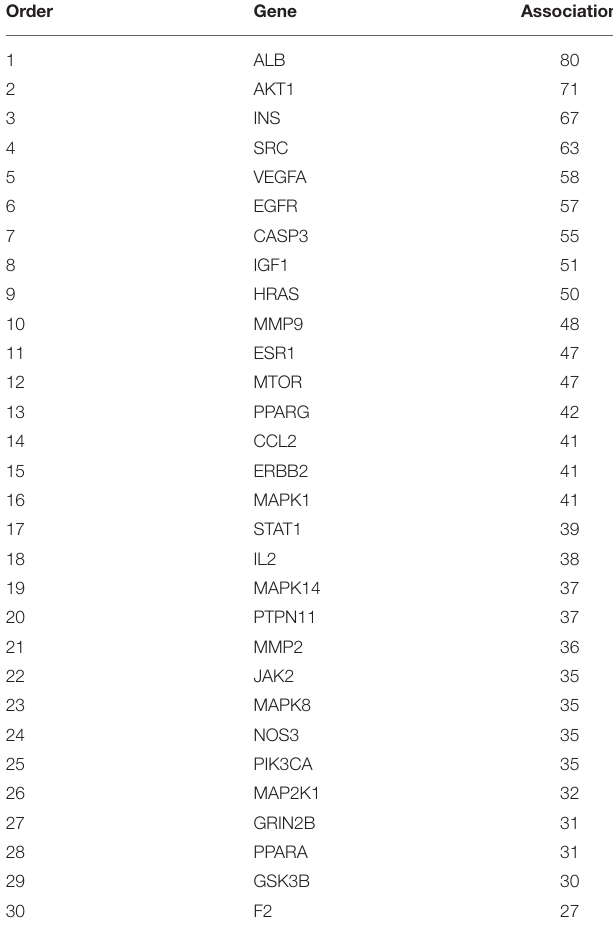
TABLE 1 | DNP associated genes.